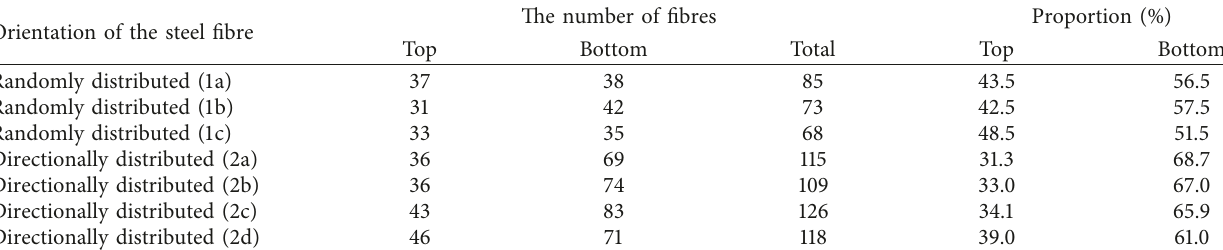
Figure 12: Nonuniform and uniform distribution of fibres of the same orientation in components subjected to tensile loading. (a) The directed fibre distribution in a faulty transverse cross section. (b) The directed fibre distribution in a nonfaulty transverse cross section. Table 1: The uniformity of the steel fibre